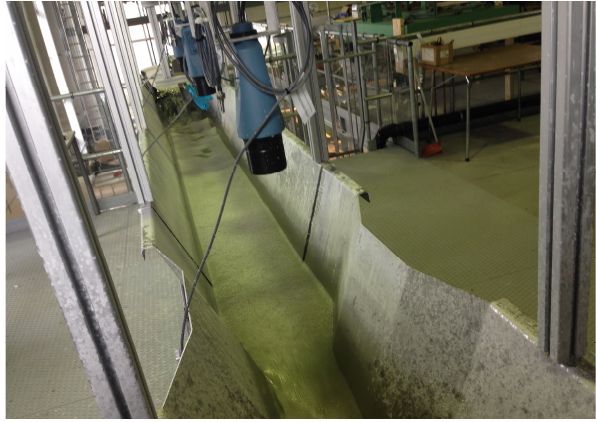
Figure 4: Rig at USN with hanging level sensors and venturi flume